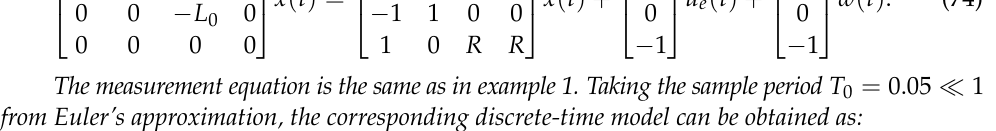
( b ) The second state component. ( c ) The third state component. ( d ) The fourth state component.